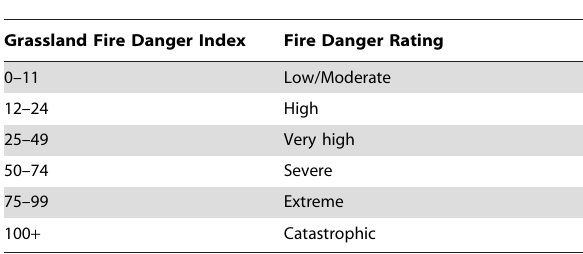
Table 1. Australia’s national forecast fire danger rating